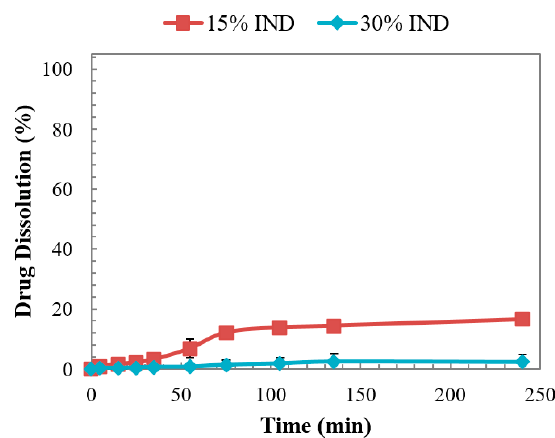
Figure 7. Dissolution of injection moulded tablets of PVPVA-IND solid dispersions in pH 1.2 dissolution medium.